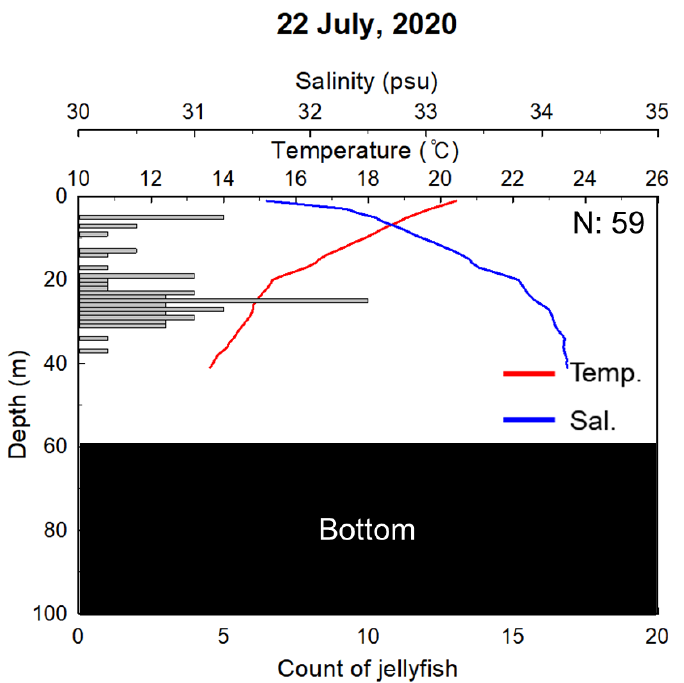
Figure 18. Distribution by water layers in the Gijang coastal waters sea (22 July, 2020). Table 12. Distribution density of jellyfish using the echo counting method in the Gijang coastal wa- ters sea (7/22).